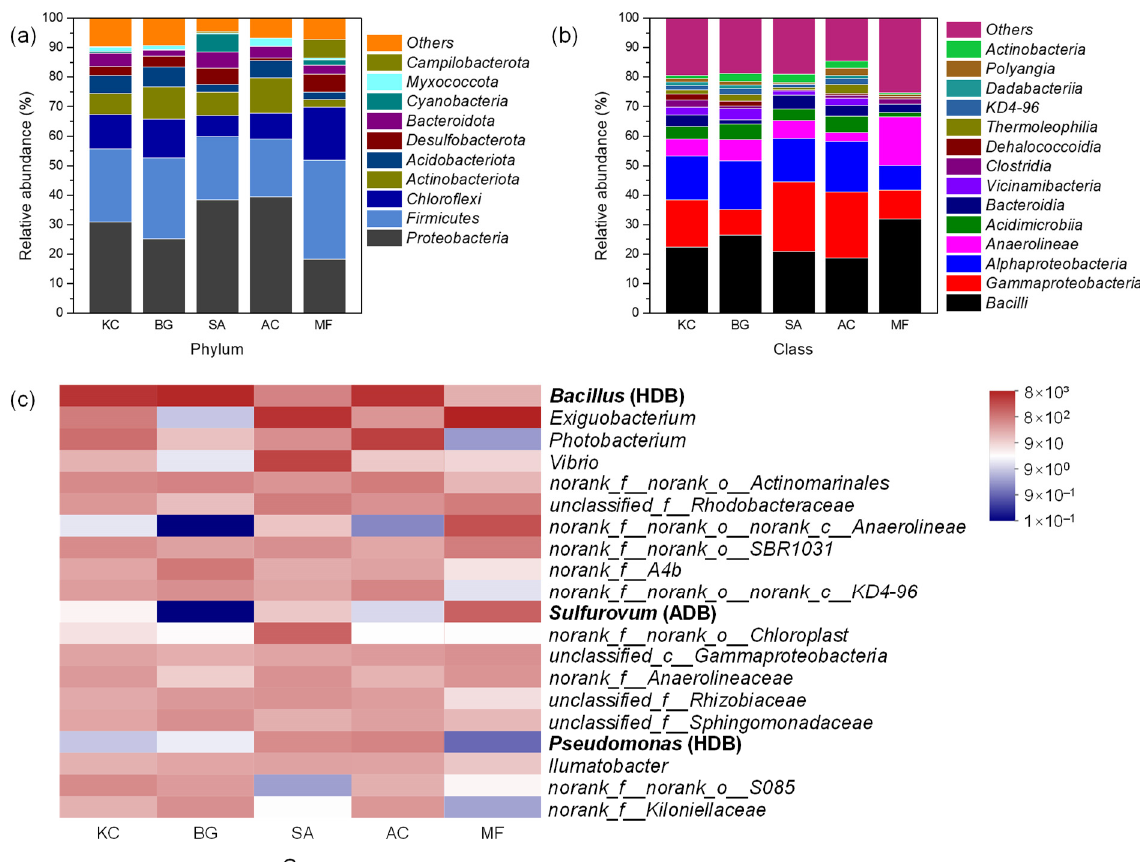
Figure 7. Distribution of phylogenetic taxa at ( a ) phylum level, ( b ) class level, and ( c ) genus level. The genera in bold indicate heterotrophic denitrifying bacteria (HDB) and autotrophic denitrifying bacteria (ADB).